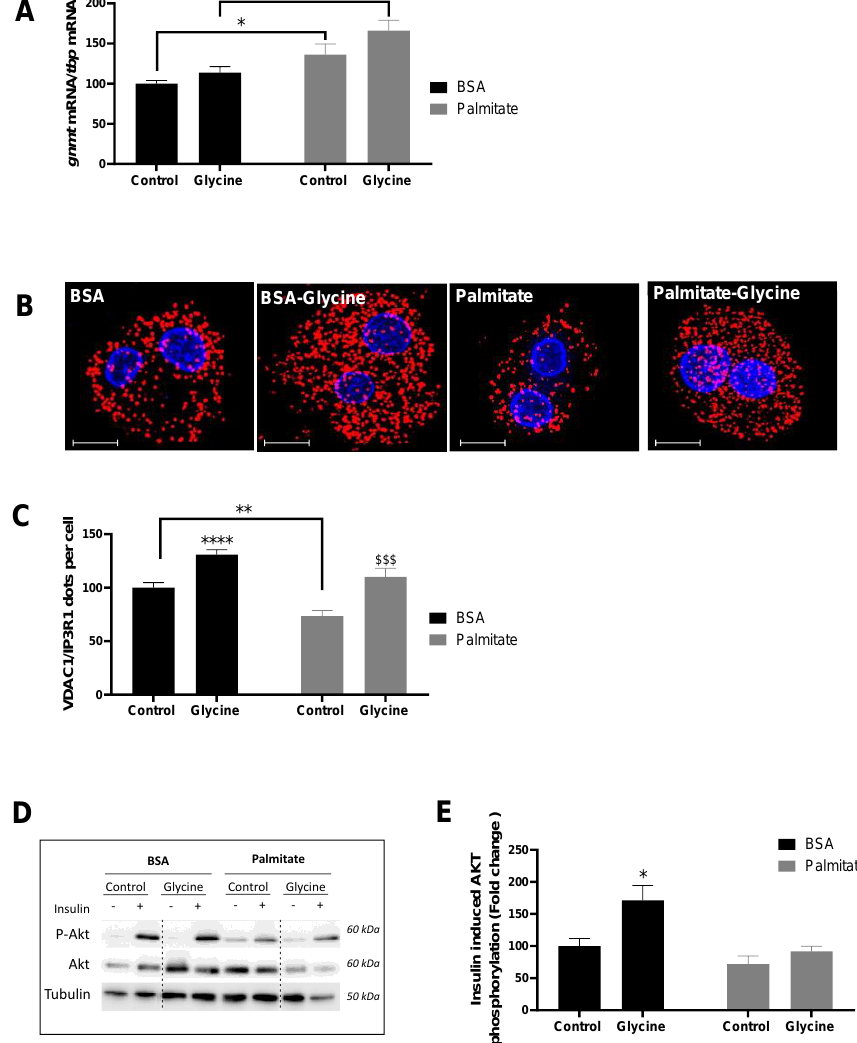
Figure 1. The impact of glycine on MAM integrity and insulin response in primary rat hepatocytes. Primary rat hepatocytes were treated with glycine (5 mM) for 18 h under basal (BSA) or lipotoxic (Palmitate, 500 µ M) conditions. ( A ) Glycine N-methyltransferase (Gnmt) mRNA expression relative to TATA box binding protein (Tbp) mRNA, ( B ) representative images (scale = 10 µ m) and ( C ) quantitative analysis of VDAC1/IP3R1 interactions per cells using in situ Proximity Ligation Assay (n = 3 series per group, n = 10 images/condition; VDAC1: Voltage Dependent Anion Channel 1; IP3R1: Inositol 1,4,5-trisphosphate receptor type1). (D) representative images and (E) quantitative analysis of insulin (10-7M)-induced Akt phosphorylation (n = 6 series per group). Comparison of all groups vs. BSA: * p < 0.05, ** p < 0.01, **** p < 0.0001; Comparison of palmitate + glycine vs. Palmitate: $$$ p <